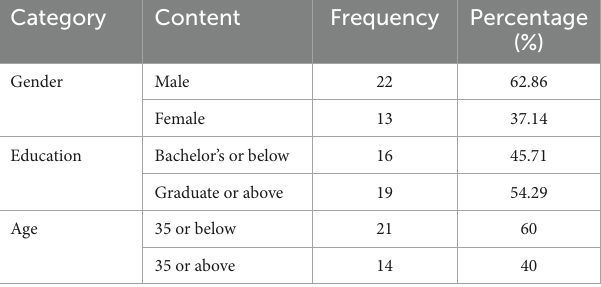
TABLE 1 The basic information of the